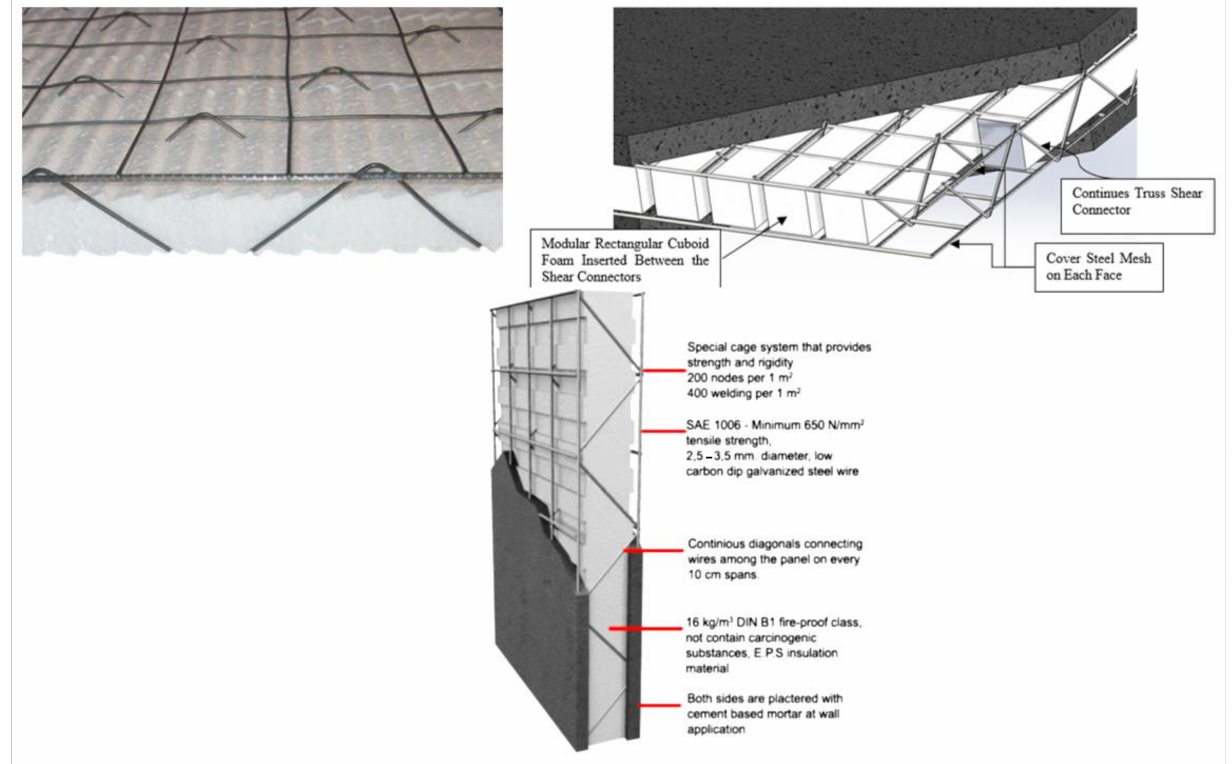
Figure 4. Continuous Warren truss-type CSP